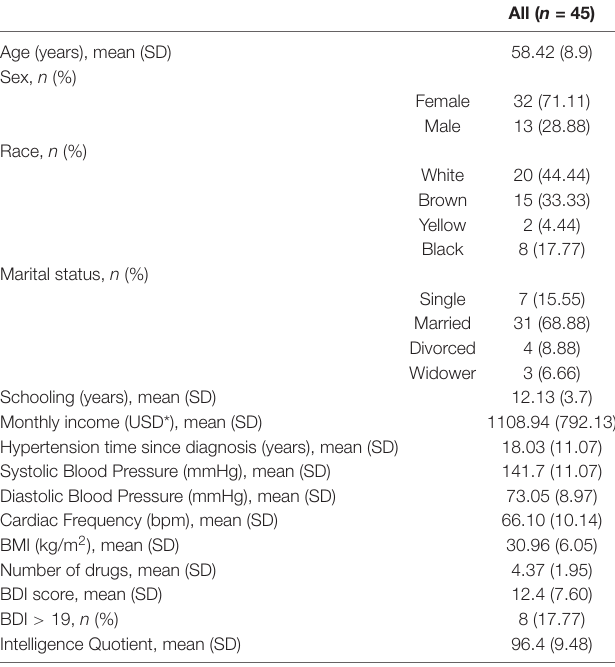
TABLE 1 | Clinical and sociodemographic characteristics of the sample ( n =